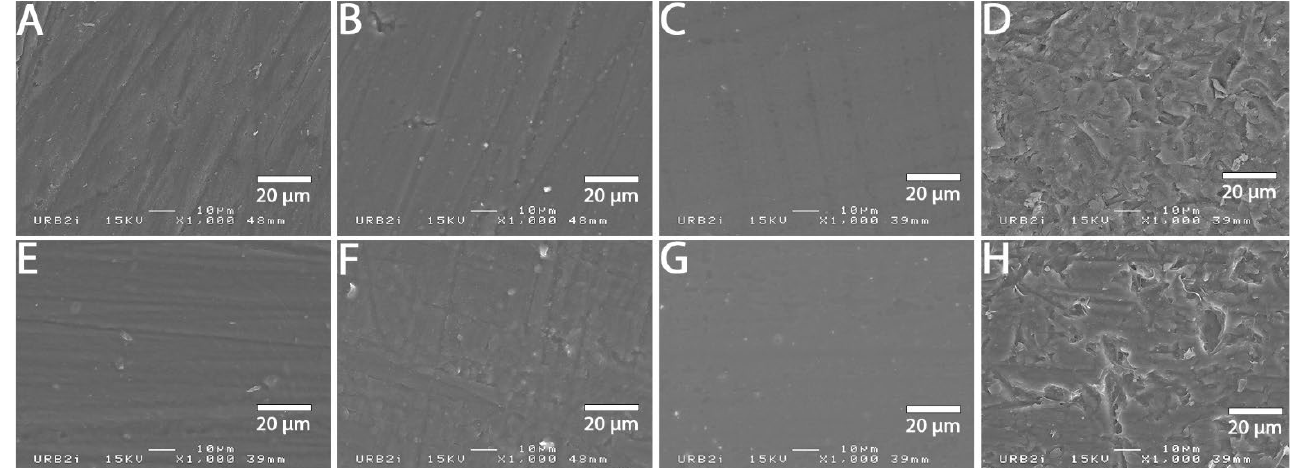
Figure 4. SEM micrograph for Katana Avencia surface (×1000 magnification) with the different sur- face treatments: ( A ) control; ( B ) polyacrylic acid; ( C ) hydrofluoric acid; ( D ) sandblasting; ( E ) 800 grit polishing + universal primer; ( F ) polyacrylic acid + universal primer; ( G ) hydrofluoric acid + uni- versal primer; ( H ) sandblasting + universal primer. Sandblasting surface treatment ( D , H ) shows a more irregular pattern surface than the other ones.